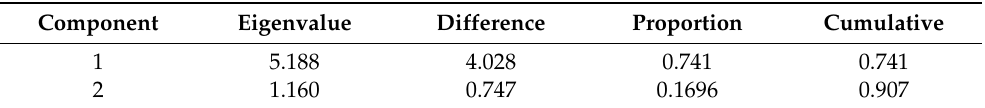
Table 5. Eigenvalues and variance explained by the first two principal components for the biophenol extracts of